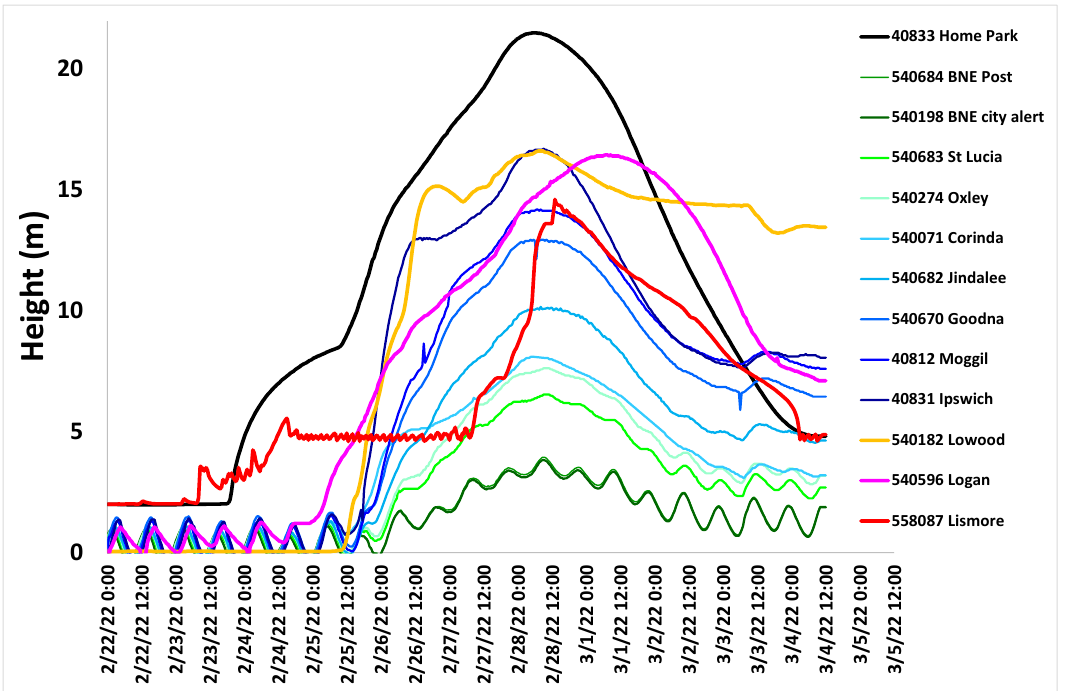
Figure 3. Temporal changes in river height between 22 February 2022 and 4 March 2022 for selected river height stations (their locations are shown in Figure 2). The numbers preceding a station’s (shortened) name represent its serial number as given by the Australian Bureau of Meteorology (BoM).